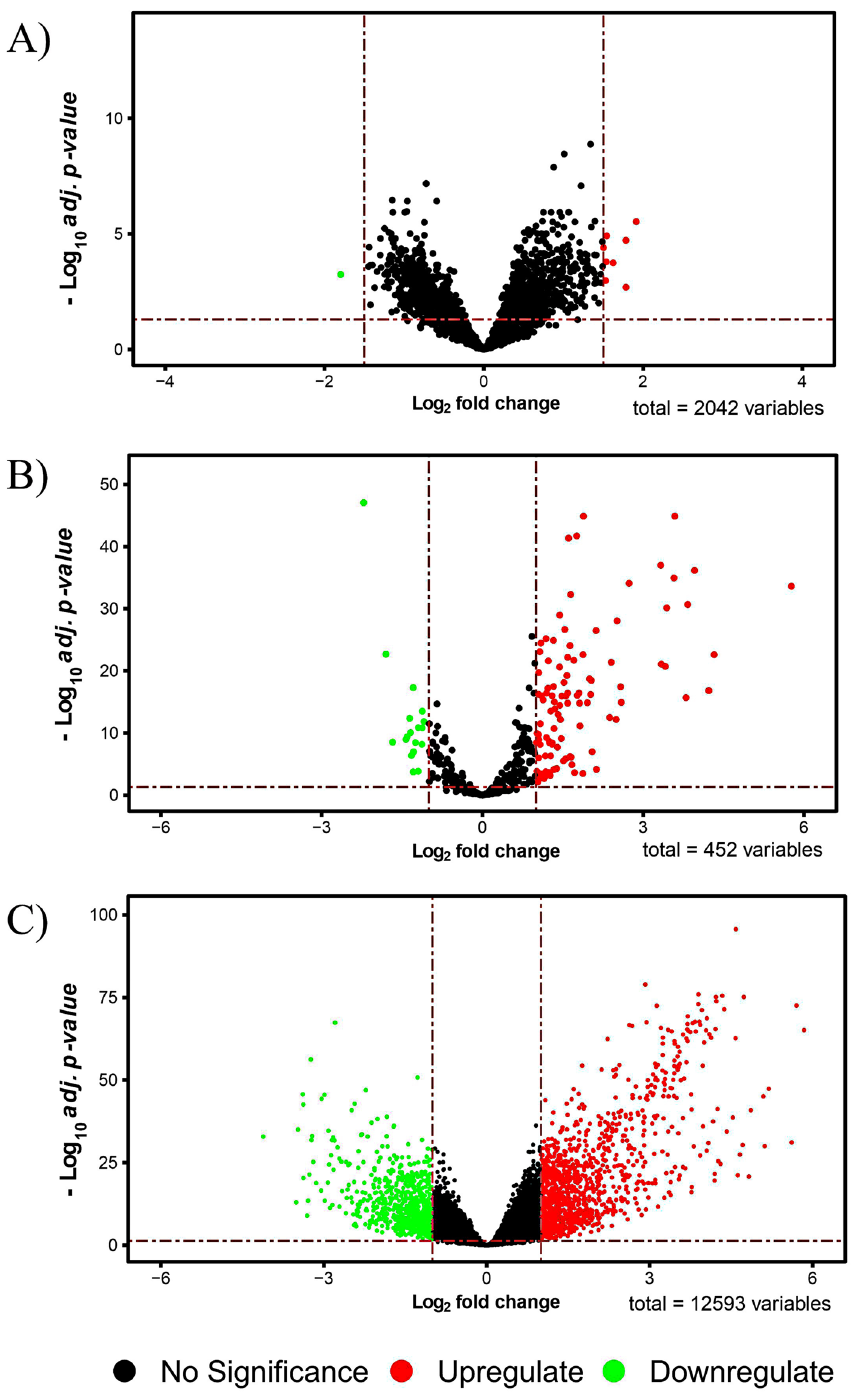
Figure 3. Volcano plots for ( A) differentially expressed circRNAs (DECs), ( B) differentially expressed miRNAs (DEMIs), ( C) differentially expressed mRNAs (DEGs). The green and red points on the graph indicate down and up expressed, respectively. Volcano plots were generated using the R package " EnhancedVolcano